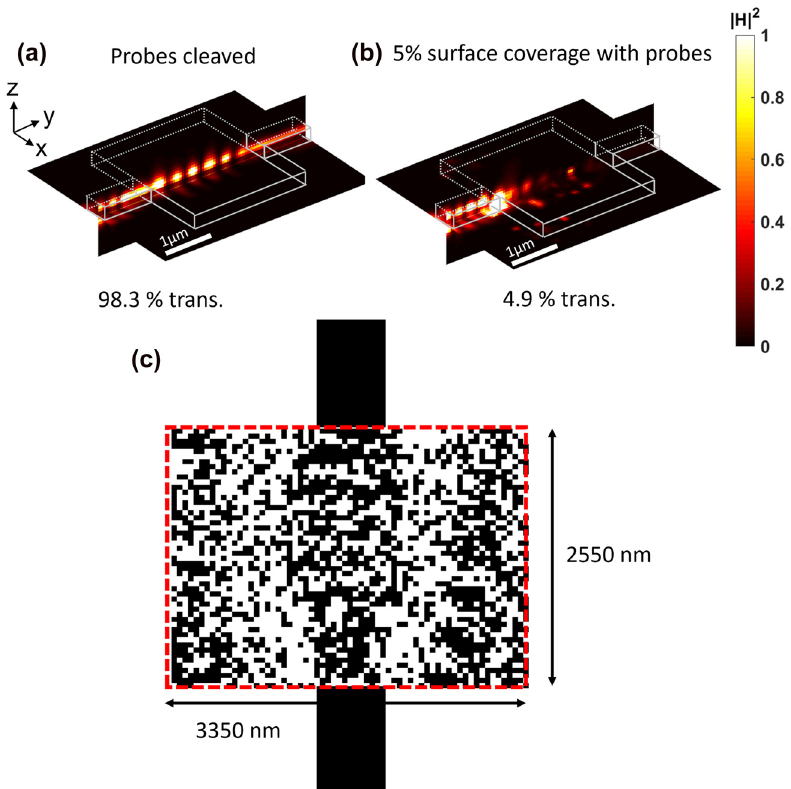
Figure 6: Inverse-designed